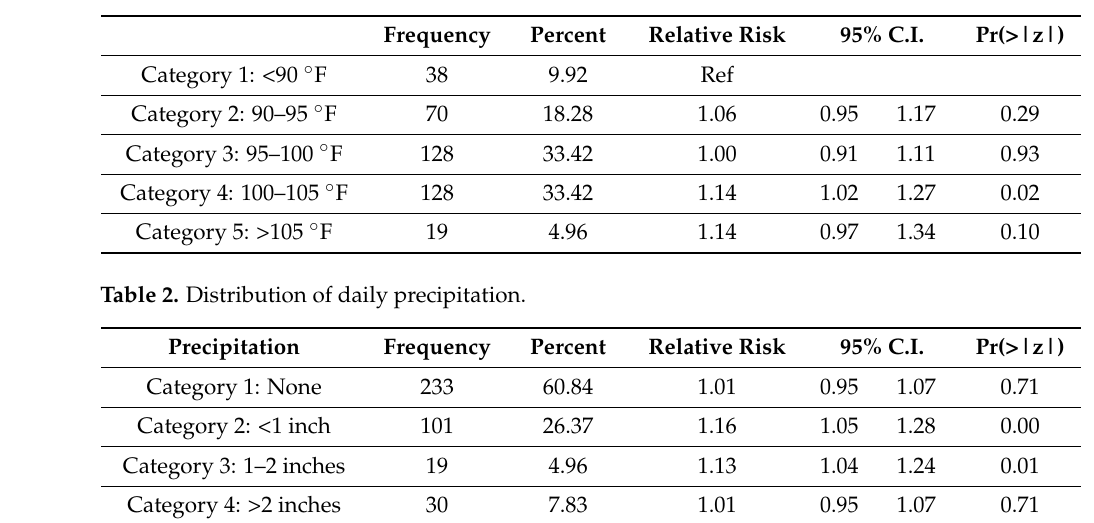
Table 1. Distribution of the daily heat index.